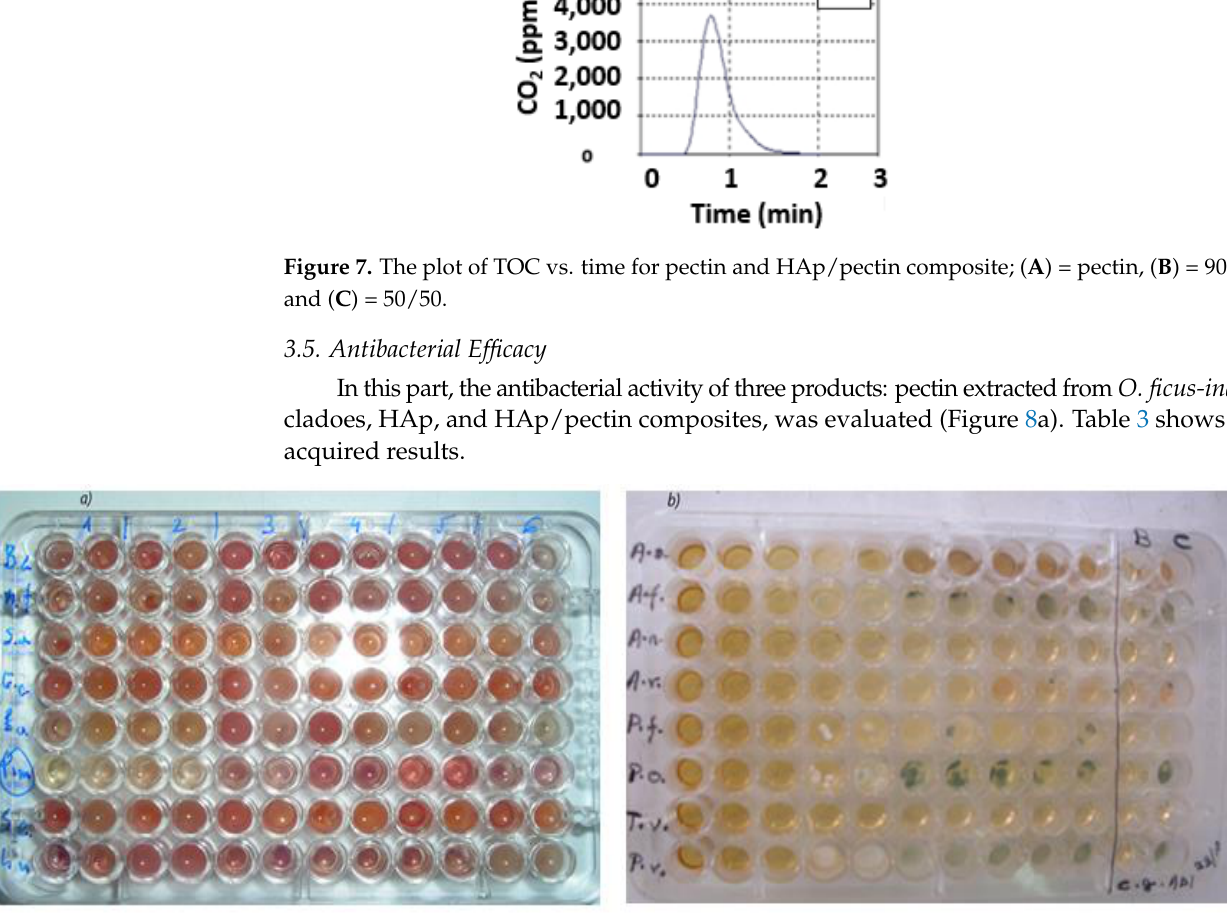
Figure 8. Antibacterial ( a ) and antifungal ( b ) effects of samples on different bacteria and fungi strains. Table 3. Antibacterial activity of Opuntia ficus-indica pectin, hydroxyapatite, and composites (HAp/pectin) in mg/mL.